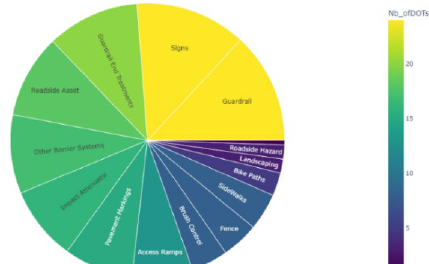
Figure 2 . Count of state DOTs that collect data for the assets included in the Roadside Asset System.